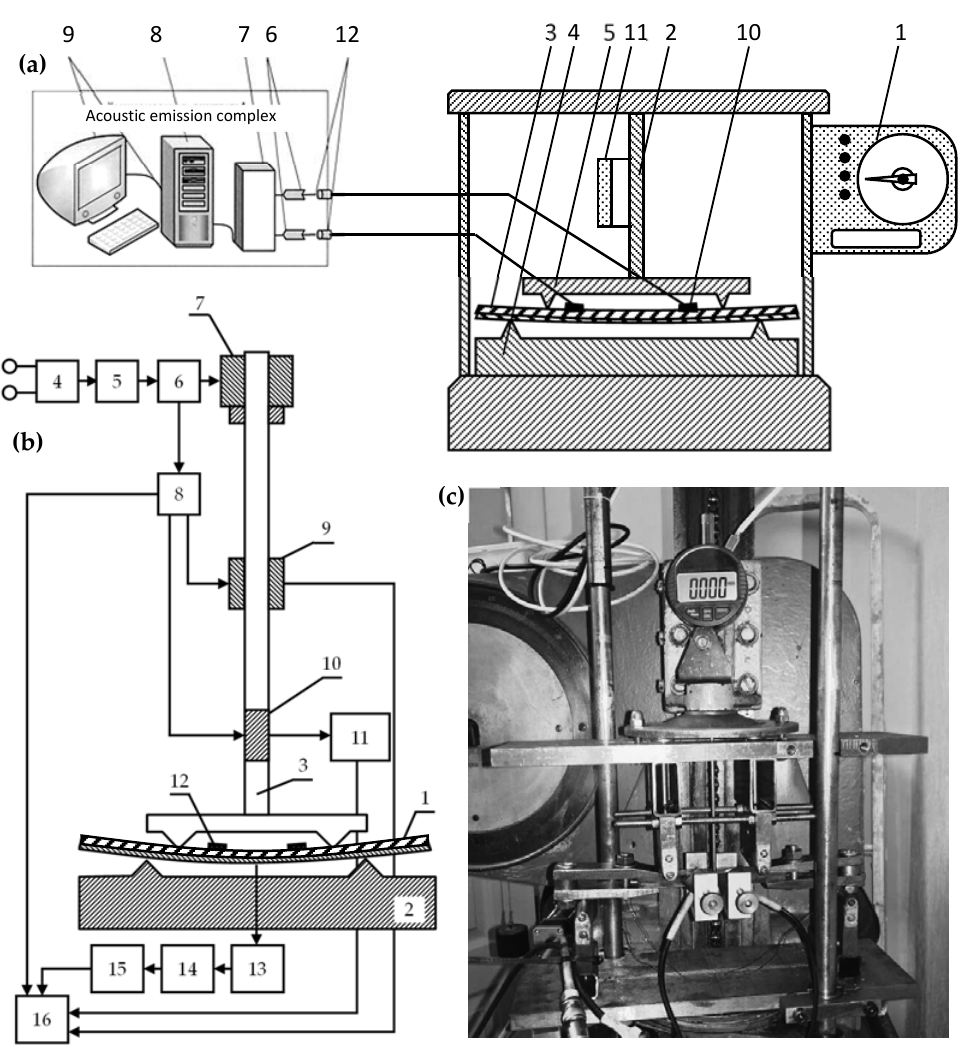
Figure 3. Experimental setup used for measurements: ( a ) block diagram of the setup, ( b ) functional diagram, and ( c ) general view of the setup.